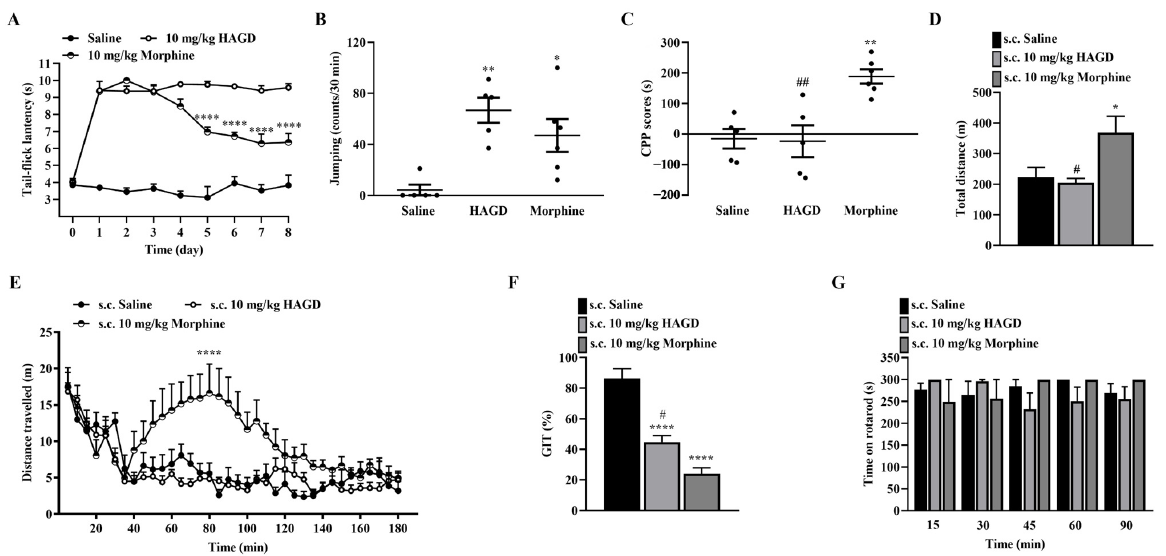
Figure 4. Evaluation of side effects of subcutaneous (s.c.) HAGD (10 mg/kg equivalent to 21.98 μ mol/kg) and morphine (10 mg/kg equivalent to 31.07 μ mol/kg). ( A ) Effects of HAGD on tolerance;